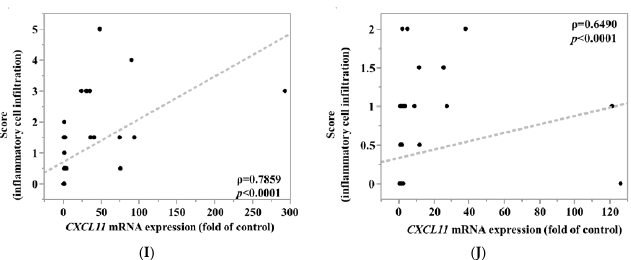
Figure 5. Relationship between inflammatory cell infiltration and gene expression of each 5 chemokines in exposed lung. ( A ) CXCL5 mRNA expression, ( C ) CCL2 mRNA expression, ( E ) CCL7 mRNA expression, ( G ) CXCL10 mRNA expression, ( I ) CXCL11 mRNA expression at 1 week after the instillation versus score of inflammatory cell infiltration and ( B ) CXCL5 mRNA expression, ( D ) CCL2 mRNA expression, ( F ) CCL7 mRNA expression, ( H ) CXCL10 mRNA expression, ( J ) CXCL11 mRNA expression at 1 month after the instillation versus score of inflammatory cell infiltration. There was relatively good correlation between inflammatory cell infiltration in lung tissues and CXCL5 , CCL2 , and CCL7 at one week and one month after intratracheal instillation.